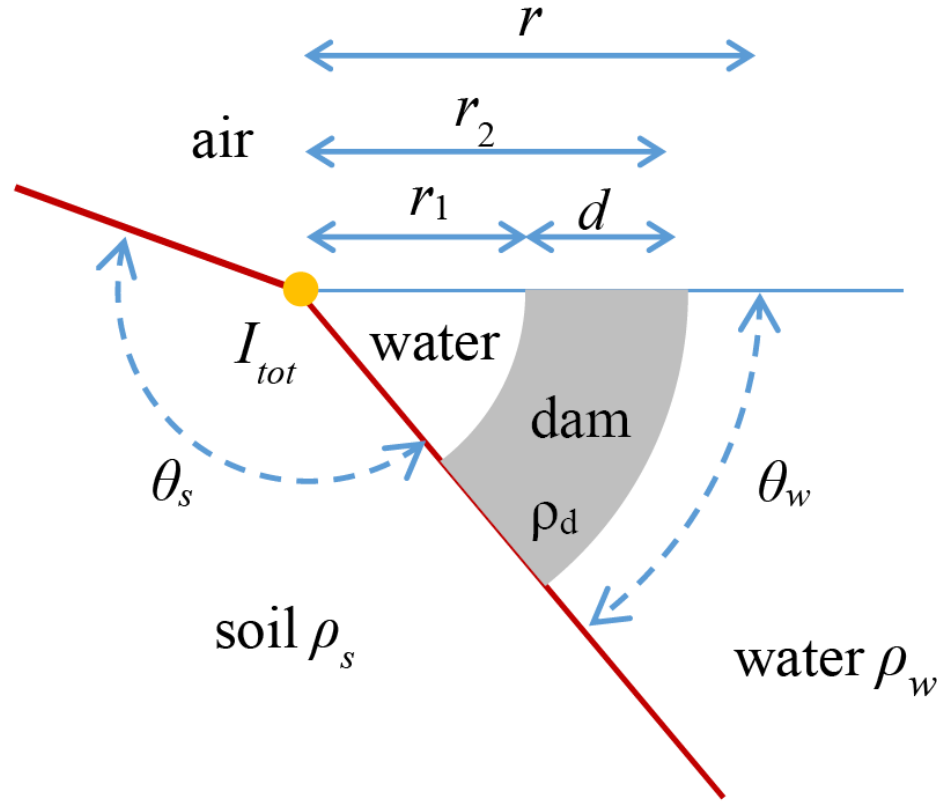
Figure 5. Simplified generalized model for placement of an electrode on the shore or in near-shore sea considering a point electrode, in spherical coordinates and using a dam–soil